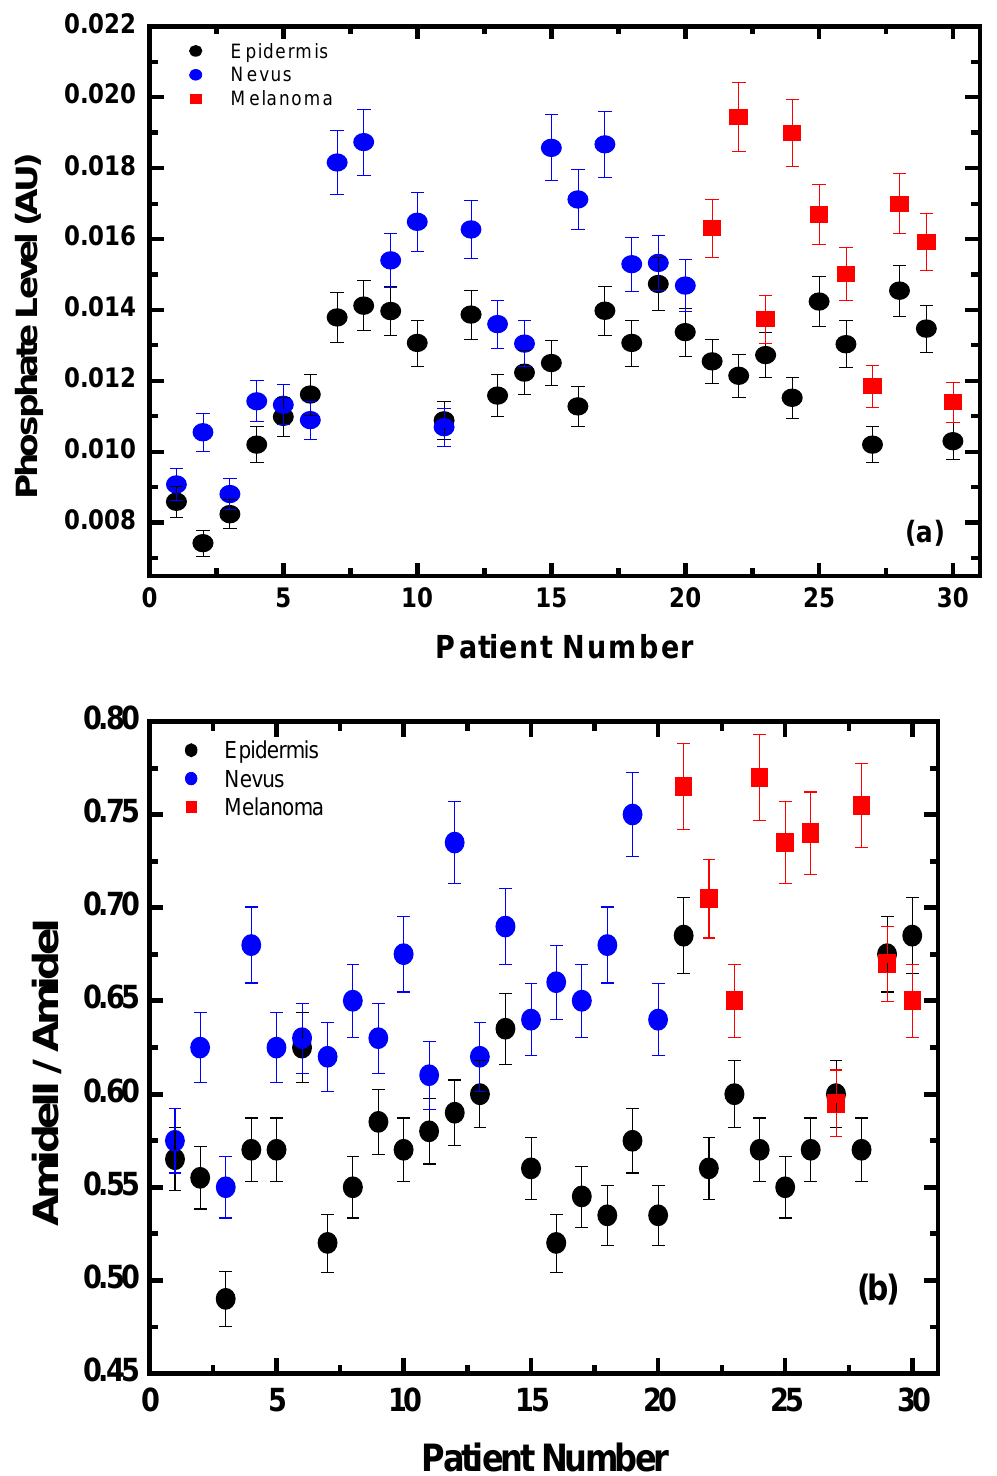
FIGURE 3. Variations in the nucleic acid levels between the epidermis and compound nevus/melanoma as quantified from the absorbance (a) integrated area of 1065–1095 cm –1 , (b) amide I/amide II, (c) I(1121 cm –1 )/I(1020 cm –1 ), and (d) I(1244 cm –1 )/I(1230 cm –1 ). The black symbols represent the epidermis and the blue circles and red squares represent the nevus and the melanoma,